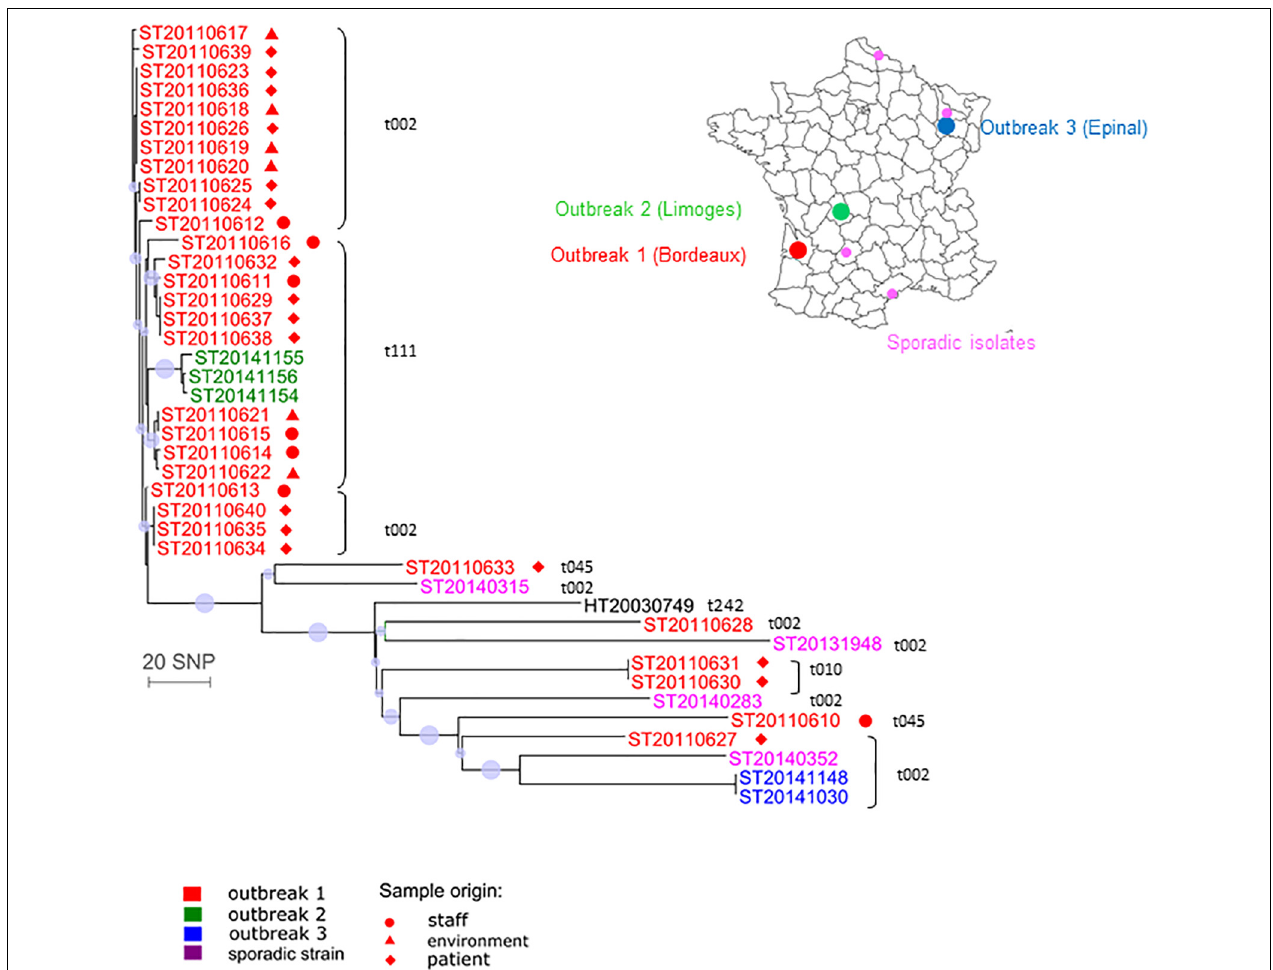
FIGURE 4 | Whole-genome sequencing for investigation of outbreaks in newborns related to the Geraldine clone MRSA. Neighbor-joining distance tree computed on the SNP between 41 Geraldine clone isolates. The leaf colors refer to the outbreak or isolate origin: red stands for Bordeaux (outbreak 1), green for Limoges (outbreak 2), blue for Epinal (outbreak 3), purple for sporadic cases, black for the Geraldine clone reference strain. Spa type information is provided near the strain identifier. The sample origin is labeled by a symbol (see legend). The dots indicate nodes supported by a bootstrap score over 80, based on 100 repetitions. The larger the dot, the higher the score. The scale represents the number of SNPs in 2,131 core